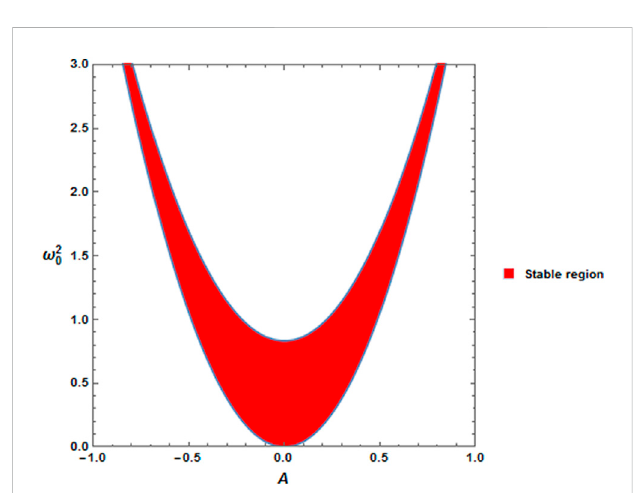
FIGURE 8 Stabilitydistributionofthesamesystem,asgiveninFigure6,except that P (cid:2) 0 .